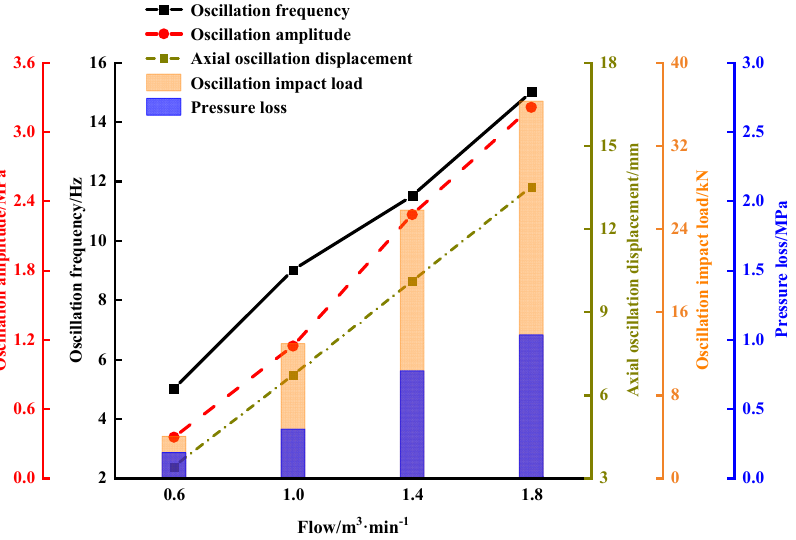
Figure 12. Influence of the flow on output characteristics with the multi − source impact oscillation speed − increasing tool.